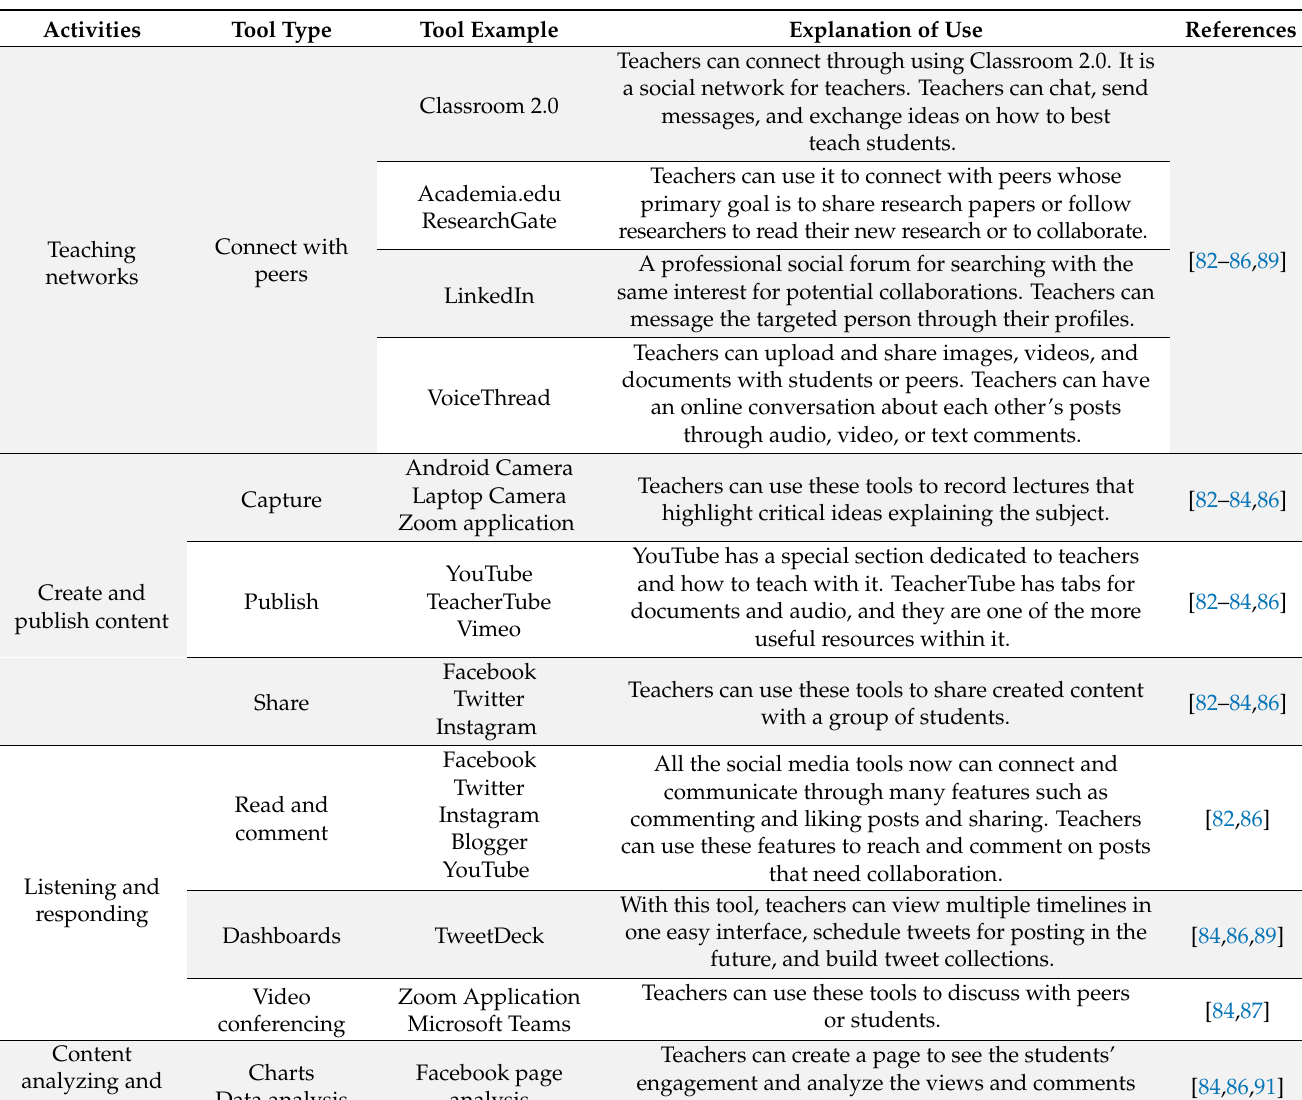
Table 7. PTE guide for social